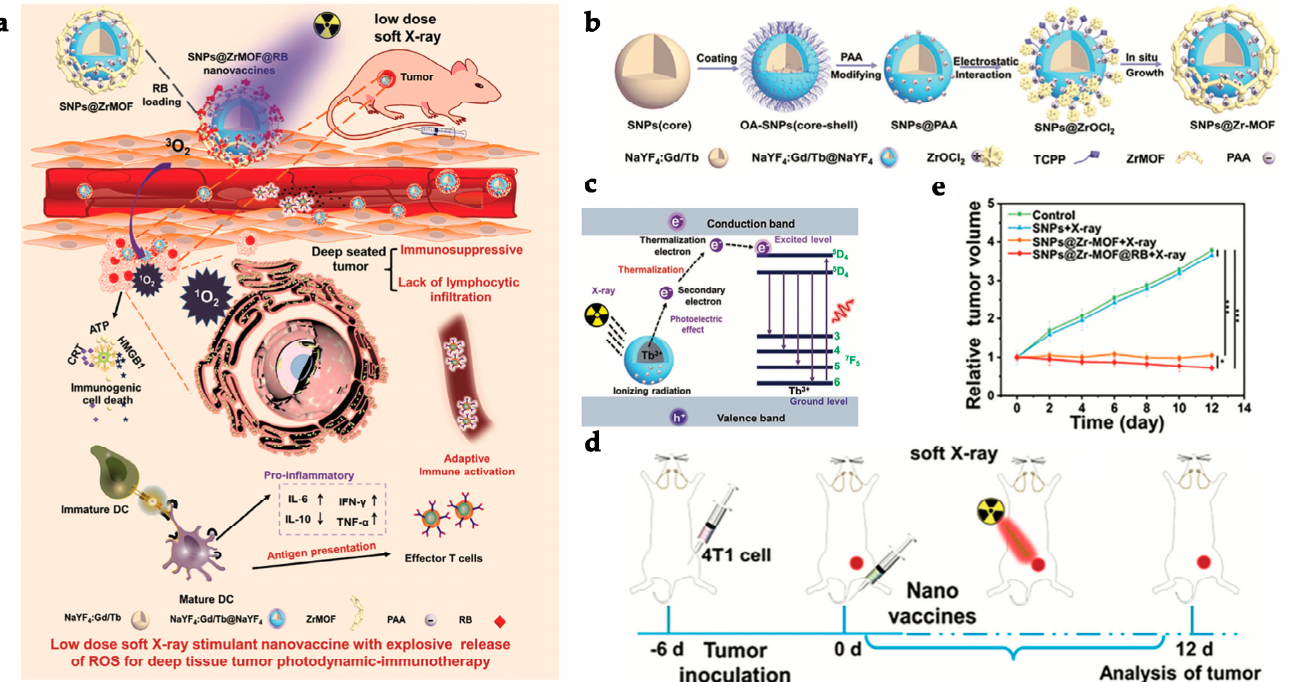
Figure 6. MOF-based synergetic PDT-immunotherapy strategy. ( a ) Combination of radiotherapy with PDT in SNPs@Zr-MOF@RB enhanced ROS production to promote a more efficient PDT in deep tumors. Robust PDT-induced ICD, led to an antitumor immune response and effective tumor cell killing. ( b ) Designing of SNPs@Zr-MOF@RB: NaYF4:Gd,Tb@NaYF4 SNP core coated by oleic acid (OA) is modified by the negatively charged polyacrylic acid (PAA) to promote the growth of a Zr- MOF at the surface through electrostatic interactions. ( c ) The photoelectric effect and Compton scattering, triggered by soft X-ray photons, generate free electrons and holes in the inner core of heavy atoms (Tb 3+ ). Thermalization of free electrons and holes into the valence and conduction bands results in the emission of XEL from the excited triplet state through a radiative transition. ( d ) 4T1 tumor cells were injected in mice and grown for 6 days. Mice were injected every 3 days and exposed to X-rays every day at a tube voltage of 10–50 kV for 5 min. Different conditions tested were (1) PBS control, (2) SNPs (3 mg/mL) + X-ray, (3) SNPs@Zr-MOF (3 mg/mL) + X-ray, and (4) SNPs@Zr-